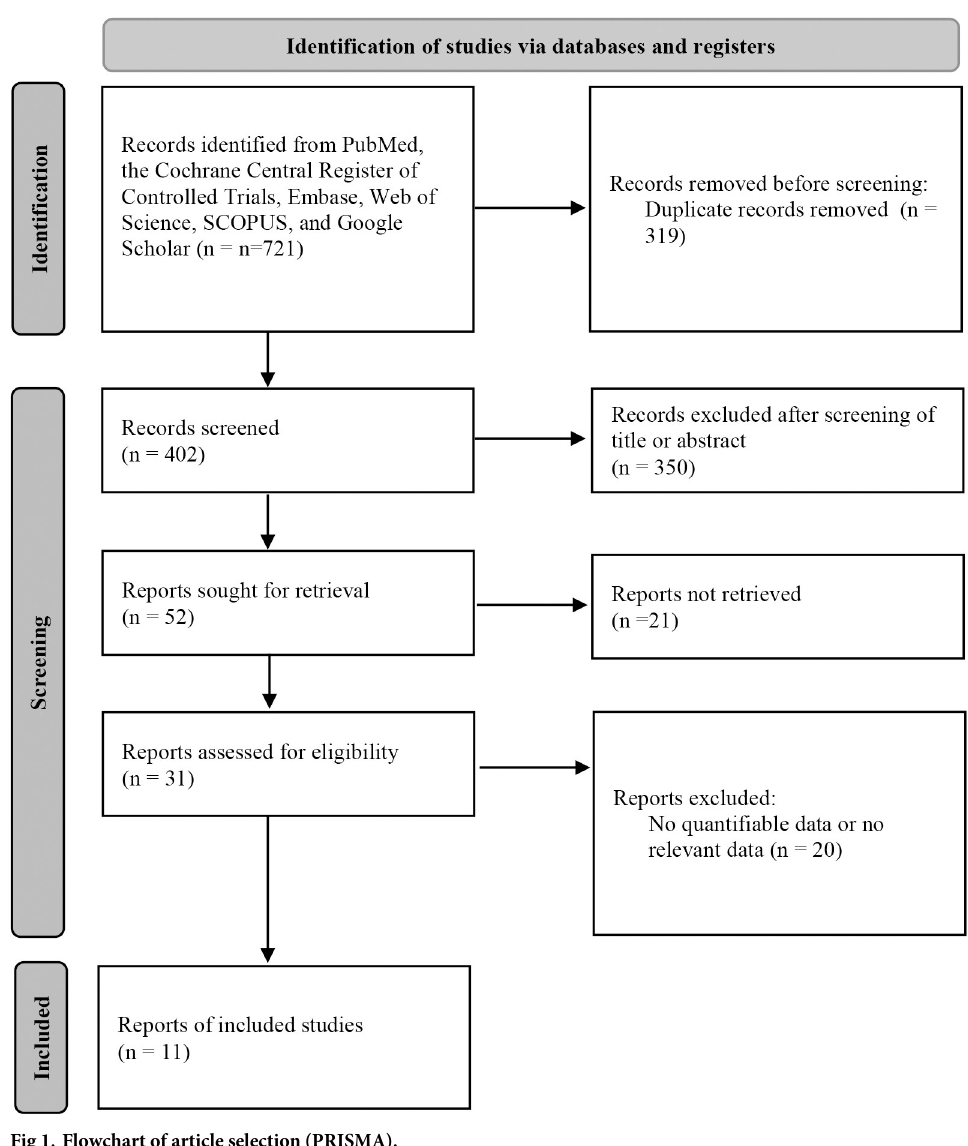
Fig 1. Flowchart of article selection